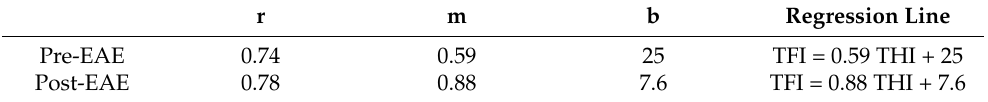
Figure 6. (THI, TFI) pair values at baseline (circles, blue) and after EAE treatment (diamonds, green) and their corresponding fitted lines. Table 3. Linear regression parameters of TFI versus THI at pre- and